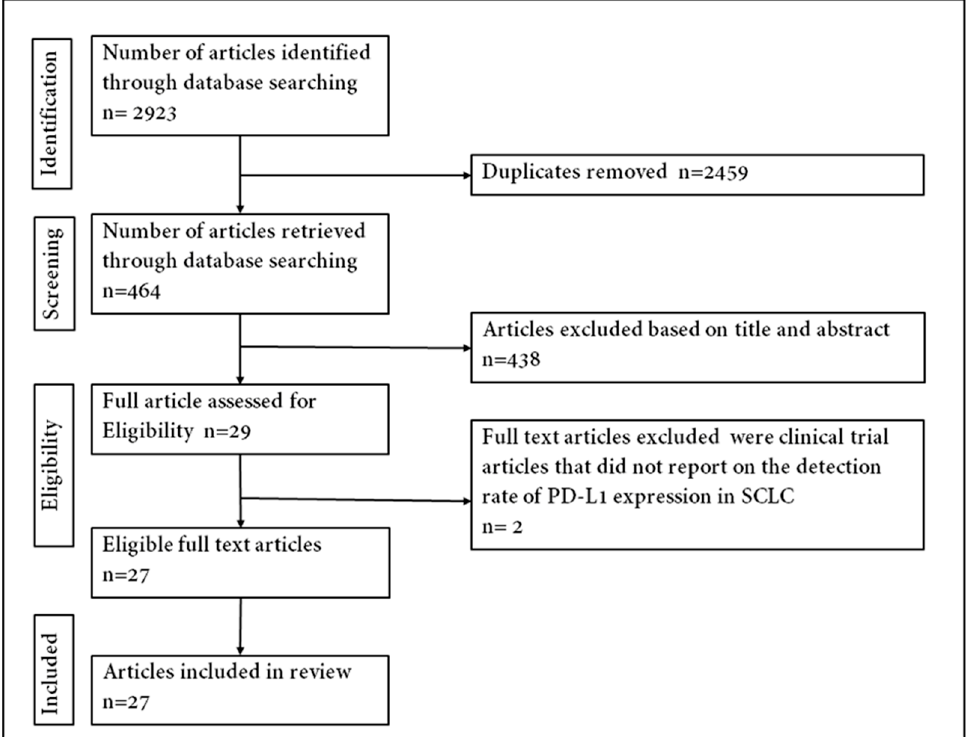
Figure 1. Flowchart of identifying eligible articles.